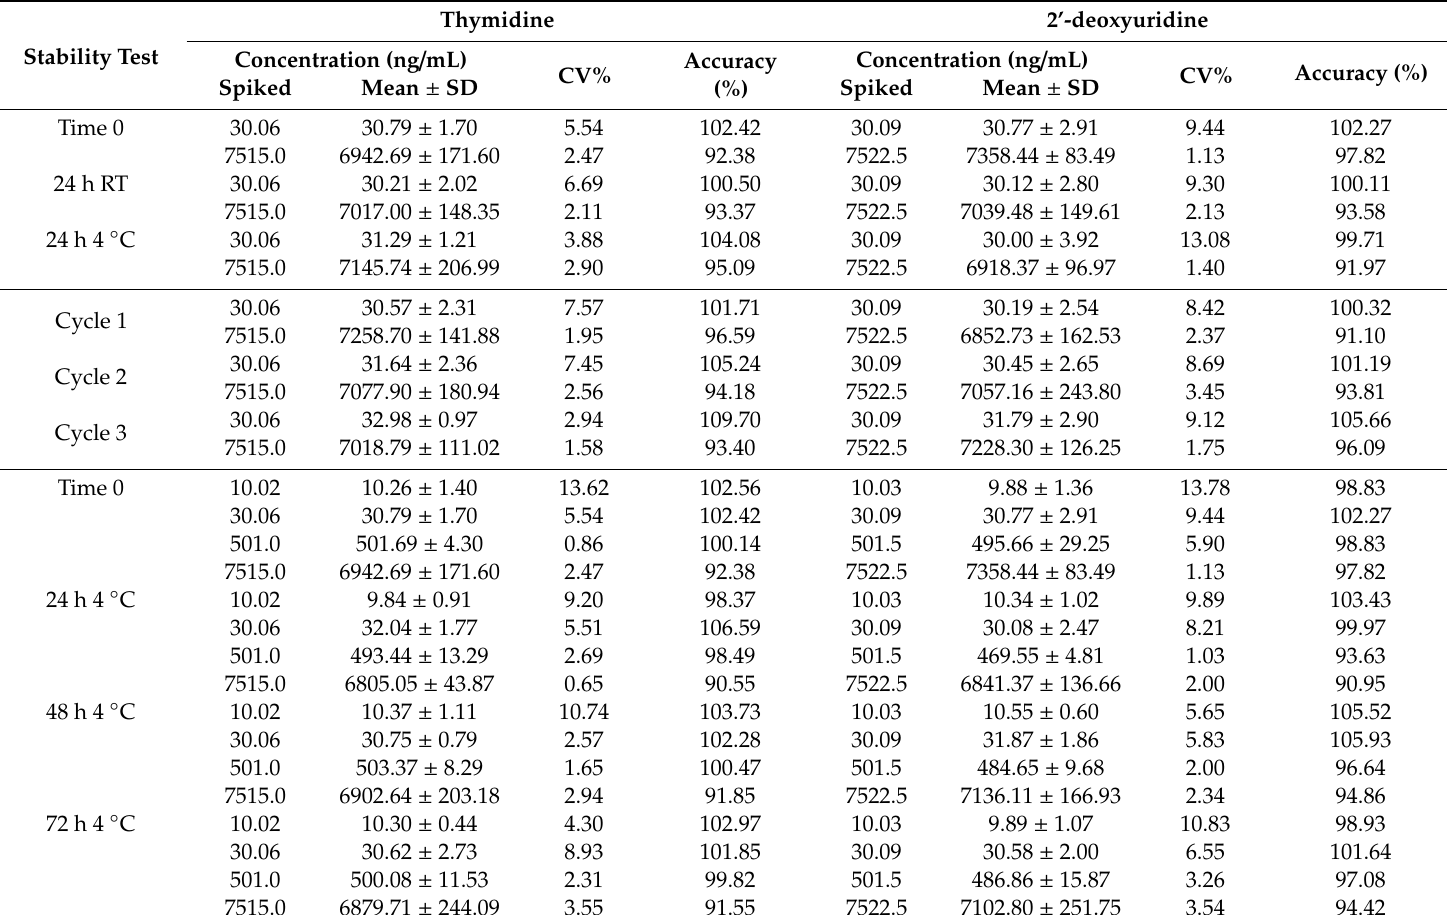
Table 3. Stability testing of thymidine and 2’-deoxyuridine in